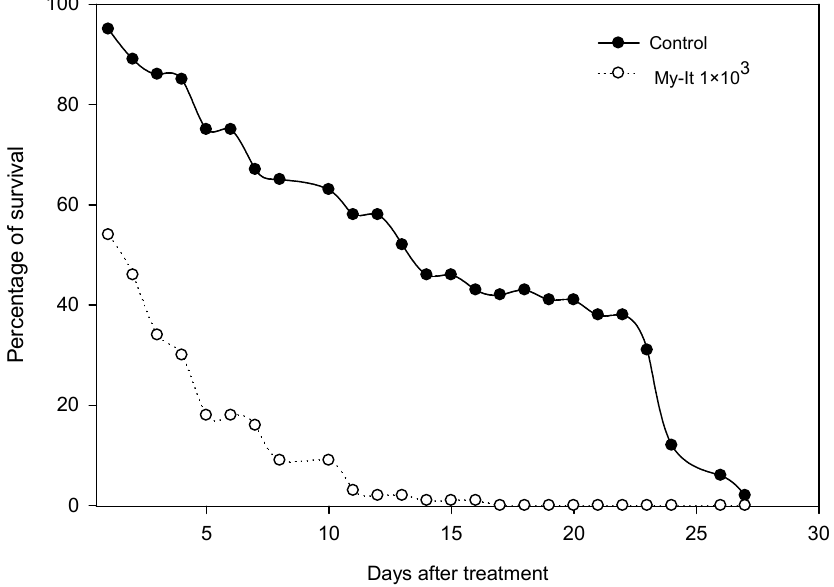
Figure 2. Survival rate of Ae. aegypti after treatment with My-It (1 × 10 3 ) conidial spores and the control. Survivorship curves di ff er at the α = 0.05 confidence interval according to log-rank statistics.